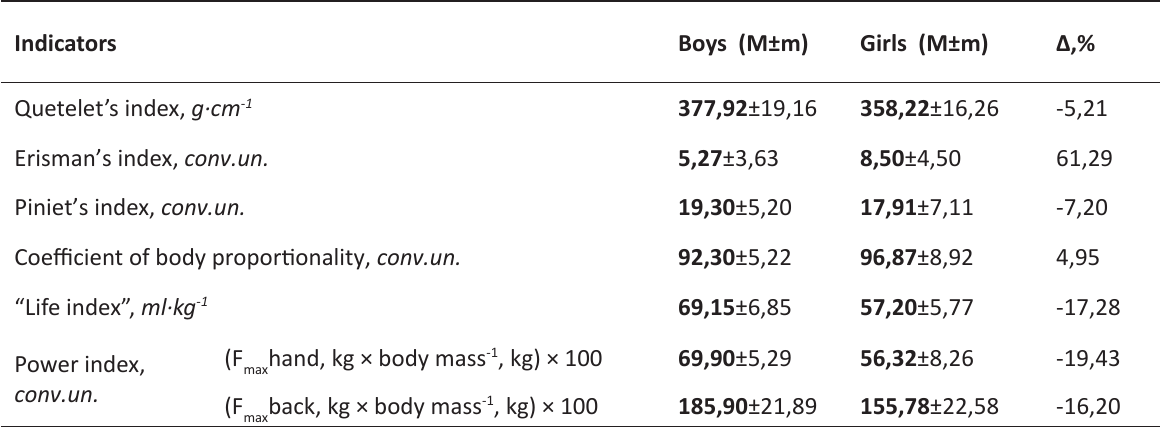
Table 2. Somatologic indices of students – members of biathlon sport-pedagogic perfection group Indicators Quetelet’s index, g·cm -1 Erisman’s index, conv.un. Piniet’s index, conv.un. Coefficient of body proportionality,